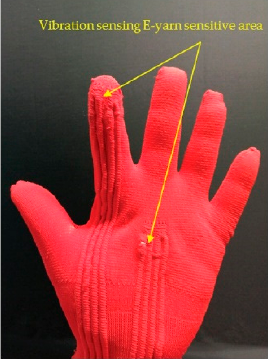
Figure 9. Photograph of the prototype vibration-sensing glove. The glove incorporates four vibration-sensing E-yarns, two at the palm, and two on the index finger.